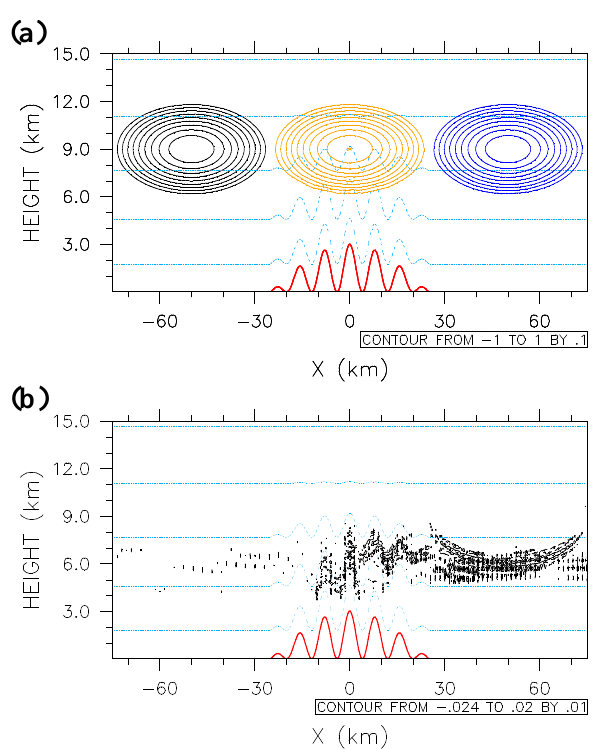
FIG. 4. Tracer advection test over the topography (red line). (a) Advective tracer at time 0 (black line), 2500 s (orange), and 5000 s (blue). The contour values are from −1.0 to 1.0 with an interval of 0.1. (b) Error at time 5000 s. The contour values are from −0.24 to 0.2 with an interval of 0.01. The numerical solutions were obtained with a grid resolution of 300x ∆ = m using 5th-order basis polynomials per element and 250z ∆ = m. The sky-blue dashed lines indicate surfaces of constant eta. The zero contour level is omitted.